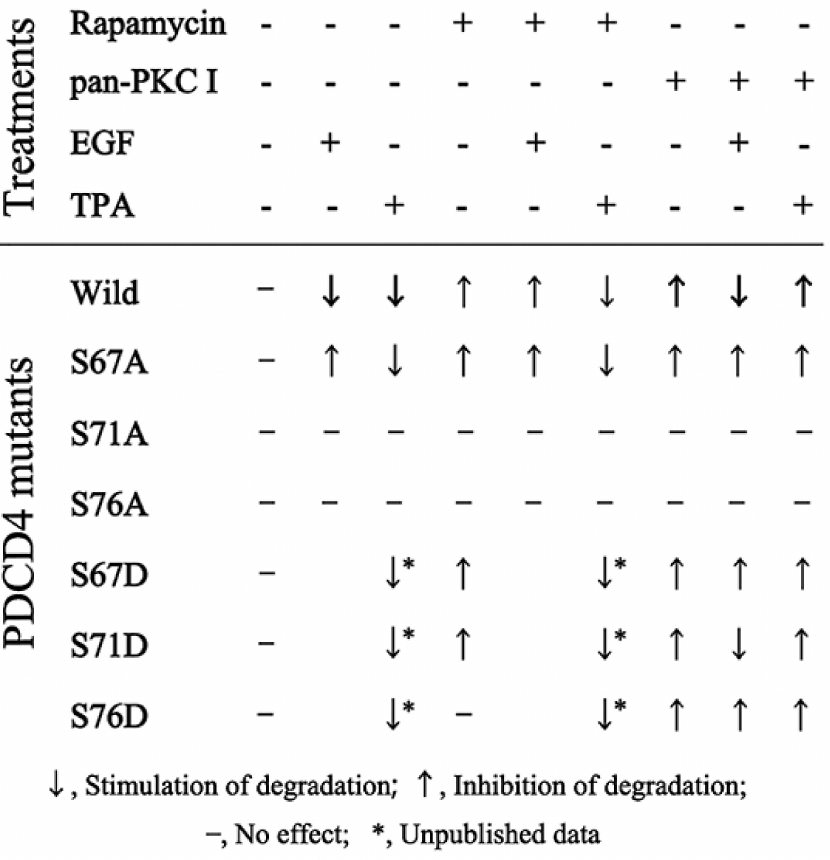
Figure 5. Expression patterns of PDCD4 mutants in the presence or absence of inhibitors with or without tumor promoters. Huh7 cells transfected with the mutant PDCD4-GFP plasmids were treated with or without EGF or TPA in the presence or absence of rapamycin or pan-PKC inhibitor (pan-PKCI). The expression of ectopic mutant PDCD4 conjugated with GFP was analyzed by Western